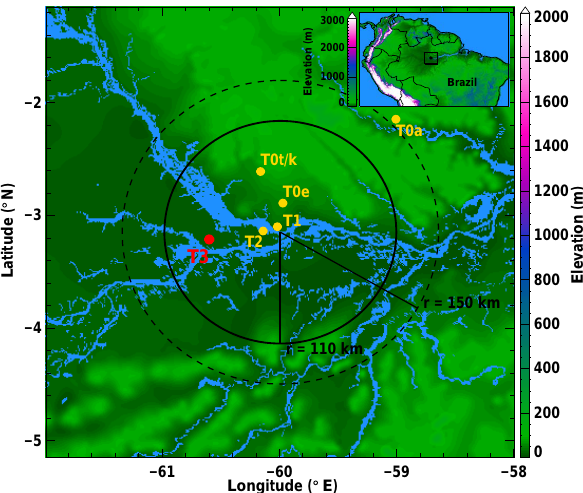
Figure 1. Location of the GoAmazon2014/5 key deployment sites and associated terrain elevation (shaded). The primary ARM AMF facilities were located at the T3 location. Range rings indicate dis- tances from the SIPAM radar location near T1. The 110km range ring is the range associated with the ARM continuous forcing dataset